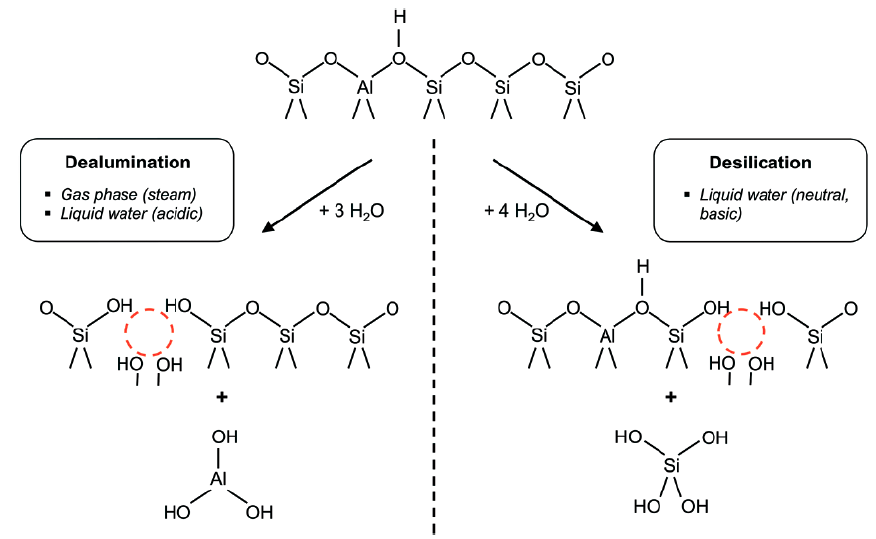
Figure 2. The schematic description of hydrolysis reactions involved in framework demetallation (Adapted from [70]. Copyright 2014 Royal Society of Chemistry).